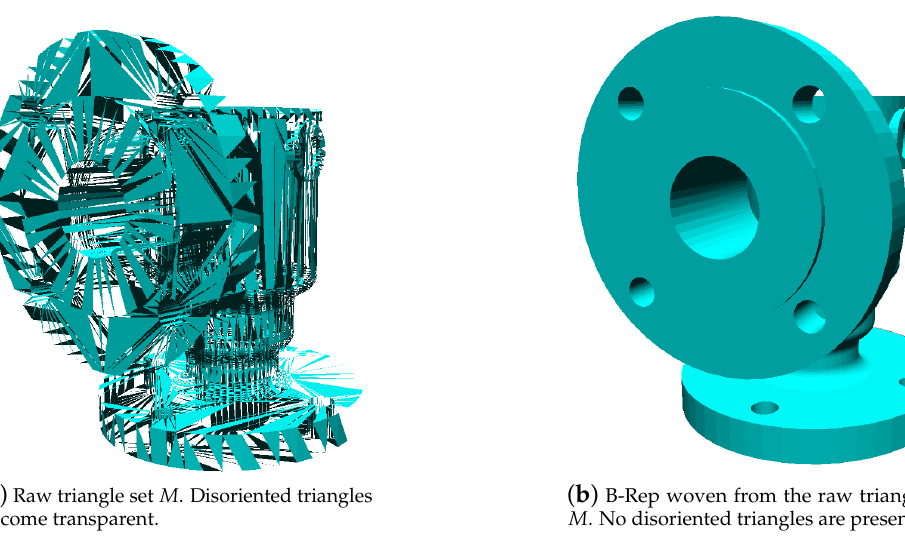
Figure 5. Input triangle set M with inconsistent FACE orientation. Output B-Rep of M . ( a ) and ( b ) displayed with culling based on the triangle